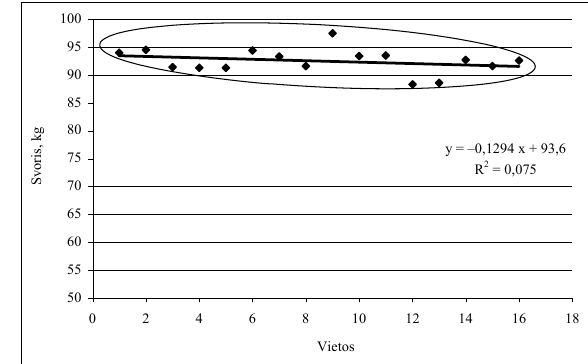
IŠVADOS Apibendrinant galima teigti, kad 2004 met ų Europos č empionate varžyb ų laim ė jim ą